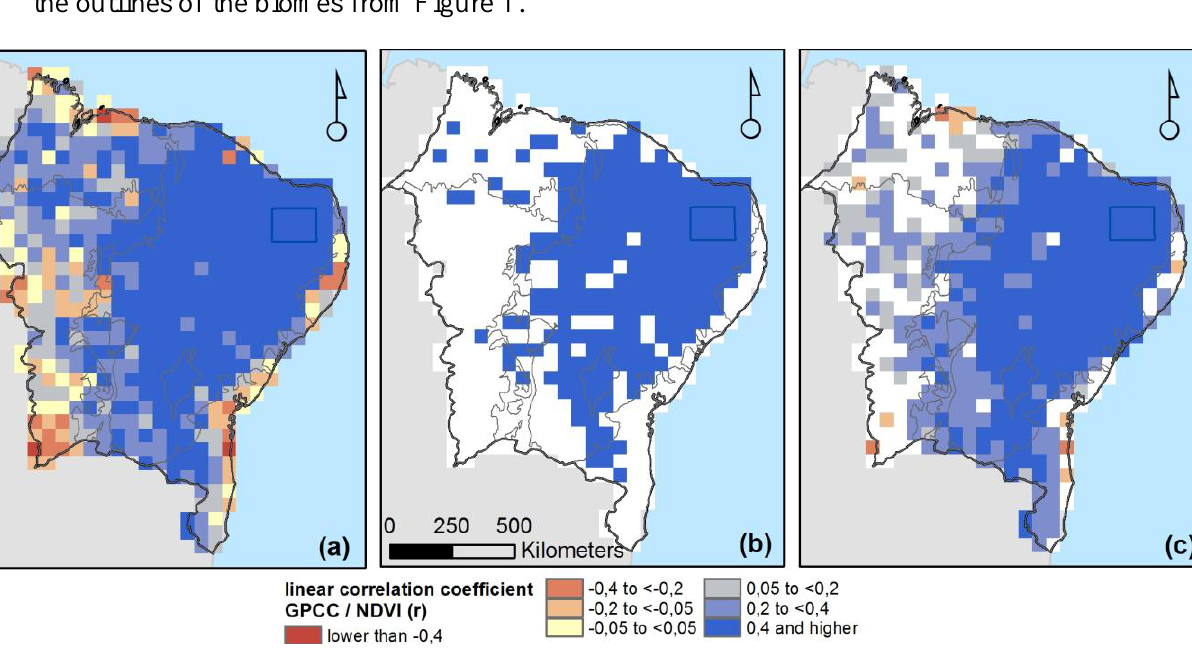
Figure 6. The results of the linear correlation analysis for NDVI3g time series (1982–2010). ( a ) The correlation coefficient (r) for GPCC and NDVI3g data (annual anomalies); ( b ) the areas with significant relation between GPCC and NDVI3g data (annual anomalies); ( c ) significant relationships (lag = +1) between monthly GPCC and NDVI3g data (monthly anomalies); white = no significance ( p < 0.01). Grey lines represent the outlines of the biomes from Figure